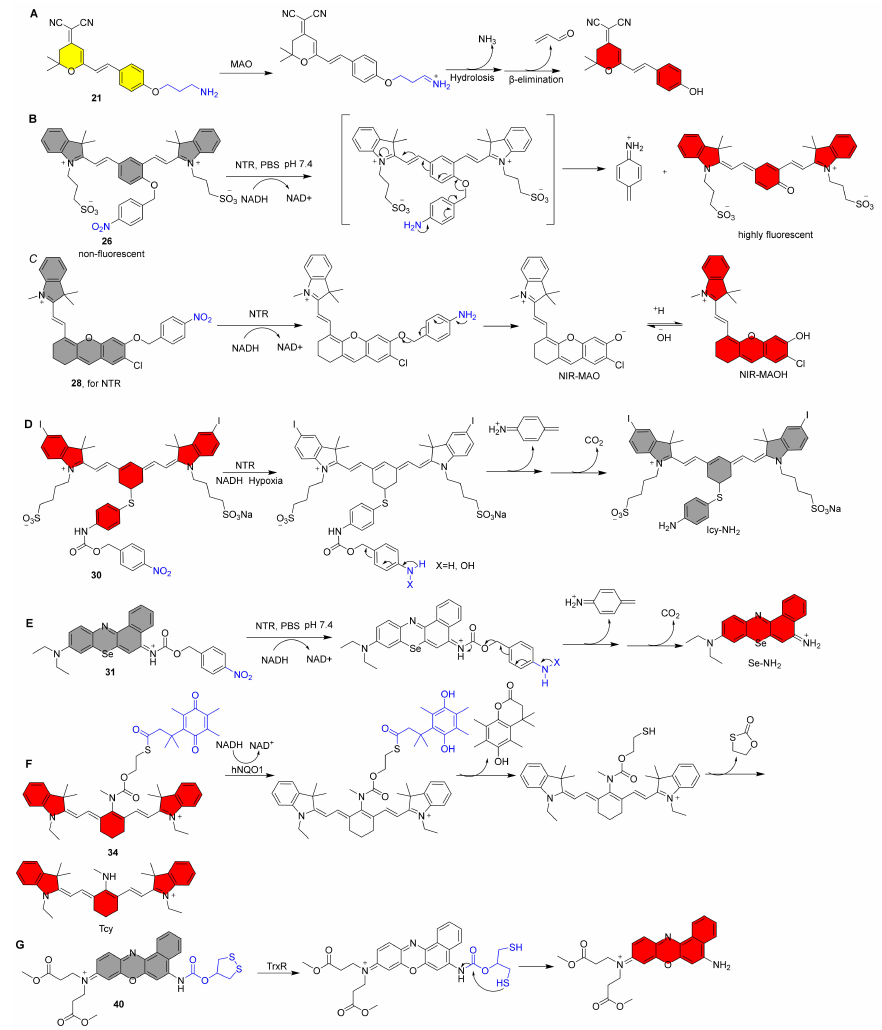
Figure 4. Recognition mechanism of probe 21 , 26 , 28 , 30 , 31 , 34 and 40